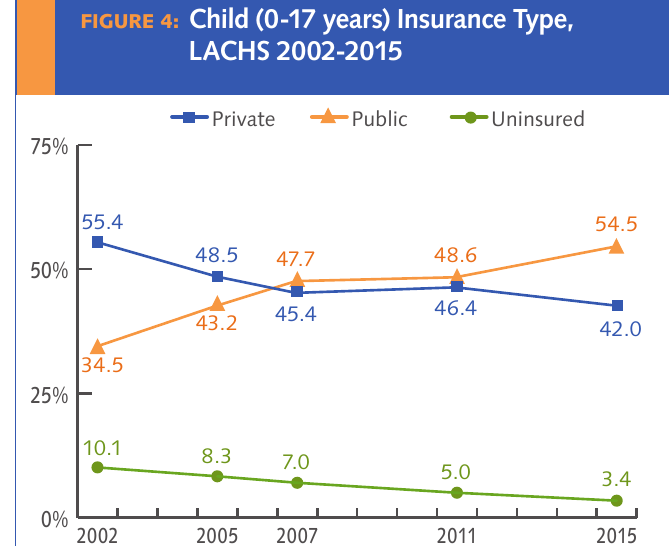
FIGURE 4: Child (0-17 years) Insurance